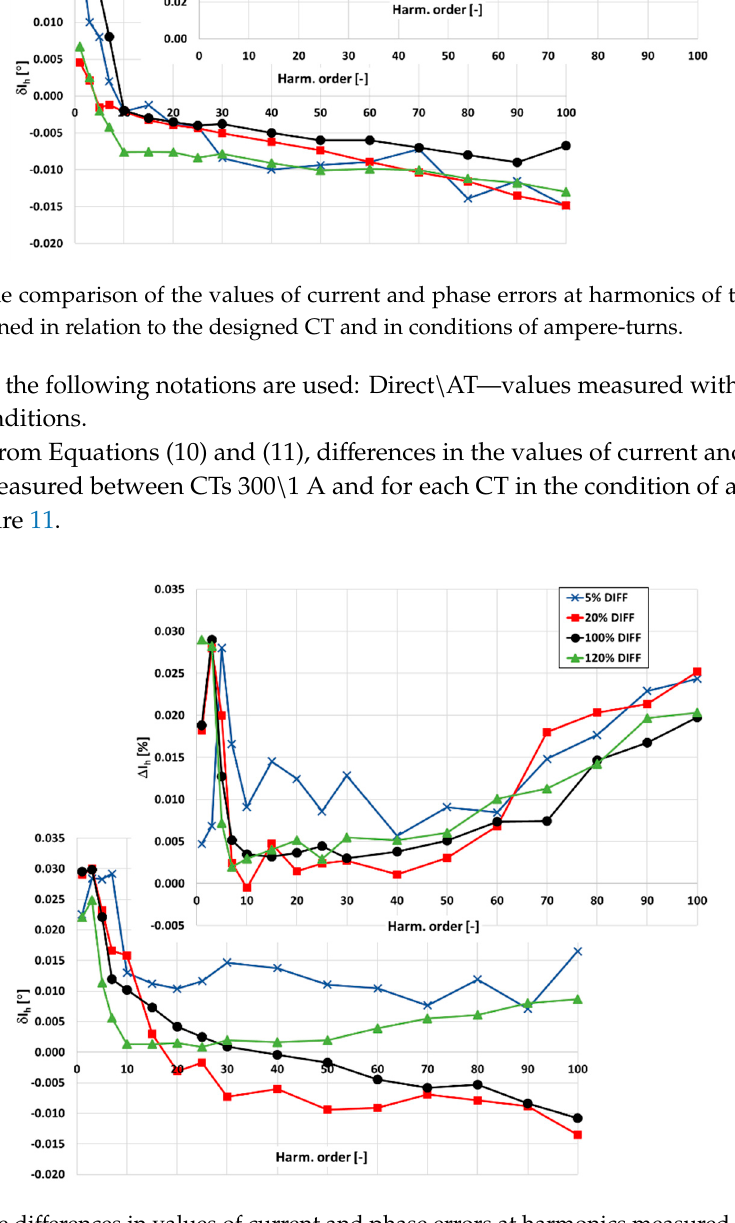
Figure 11. The differences in values of current and phase errors at harmonics measured between CTs 300\1 A and for each CT in the condition of ampere-turns.